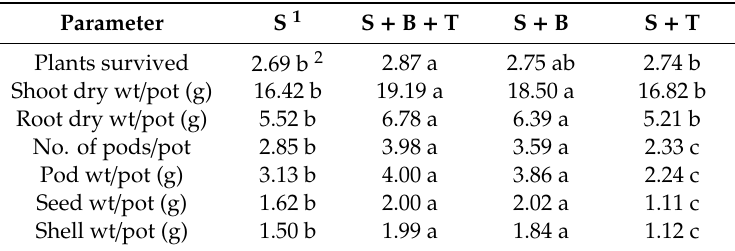
Table 5. E ff ect of individual and co-inoculation of Bradyrhizobium and Trichoderma on peanut yield